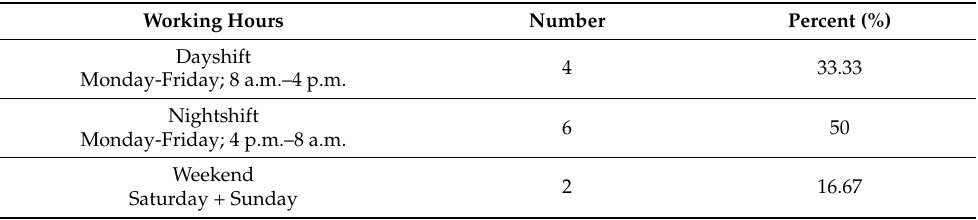
Table 2. Breakdown of when the MRI was performed. Differentiation between dayshift, nightshift, and weekend. In total, 81.8% of patients in the MRI group received a CT in the initial diagnostic phase. Two patients received solely MRI diagnostics.